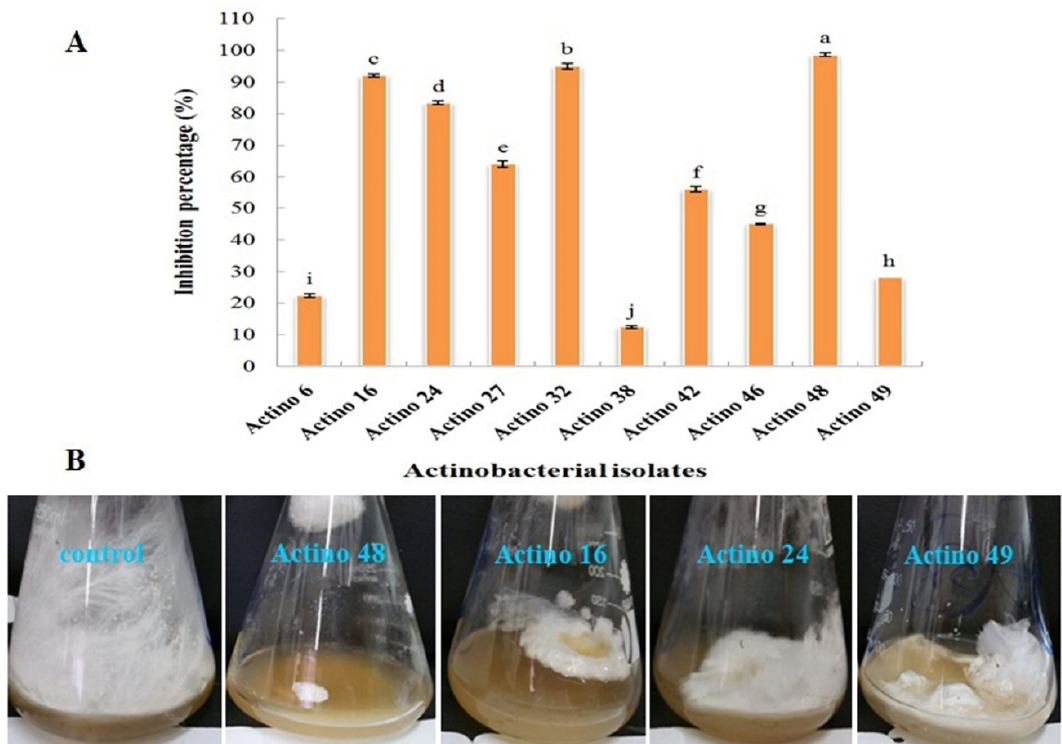
Figure 1. ( A ) Inhibition percentage of actinobacterial isolates against Sclerotium rolfsii and ( B ) antagonistic effect of actinobacterial isolates Actino 48, Actino 16, Actino 24, and Actino 49 against S . rolfsii . Flask on the left in each photo is the corresponding control (fungus) without the antagonist.